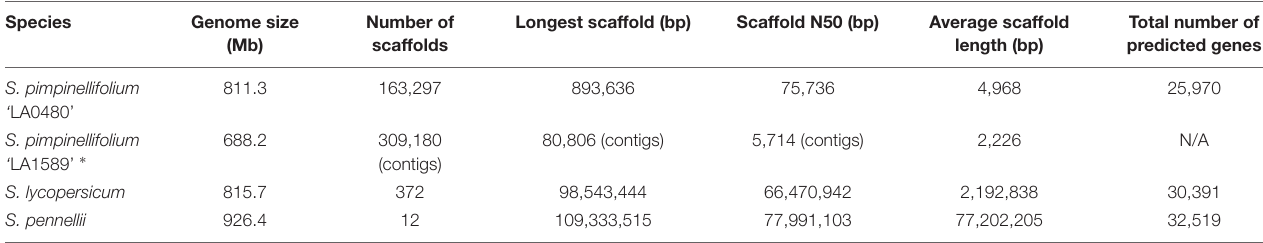
Species Genome size